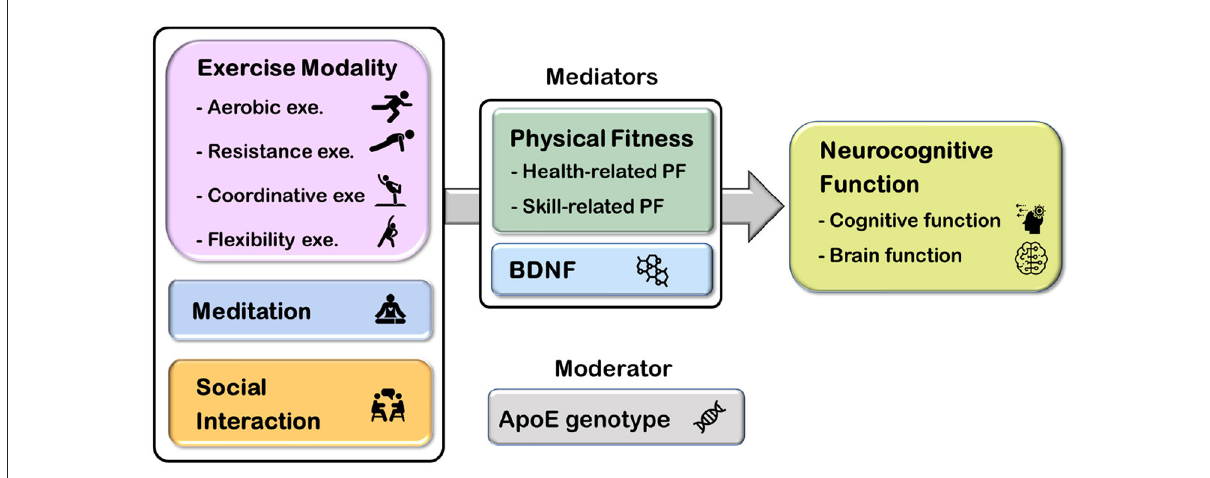
FIGURE1 The overall picture of the Western-Eastern Brain Fitness Integration Training (WE-BFit) Trial. ApoE , apolipoprotein E; BDNF, brain-derived neurotrophic factor; PF, physical fitness; exe., exercise.